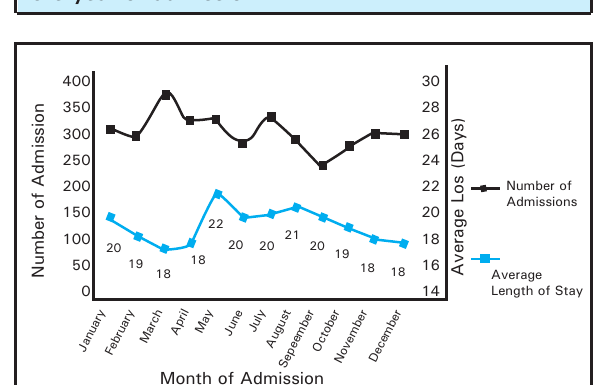
Figure 2. Pattern of distribution of number of admissions and average length of stay according to the month of